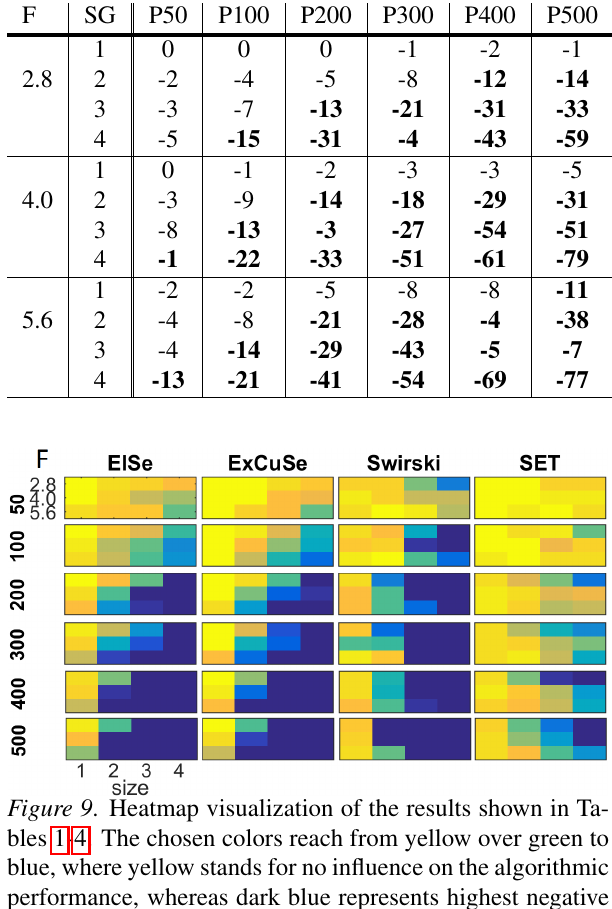
Figure 9 . Heatmap visualization of the results shown in Ta- bles 1-4. The chosen colors reach from yellow over green to blue, where yellow stands for no influence on the algorithmic performance, whereas dark blue represents highest negative influence on the performance of the pupil detection.